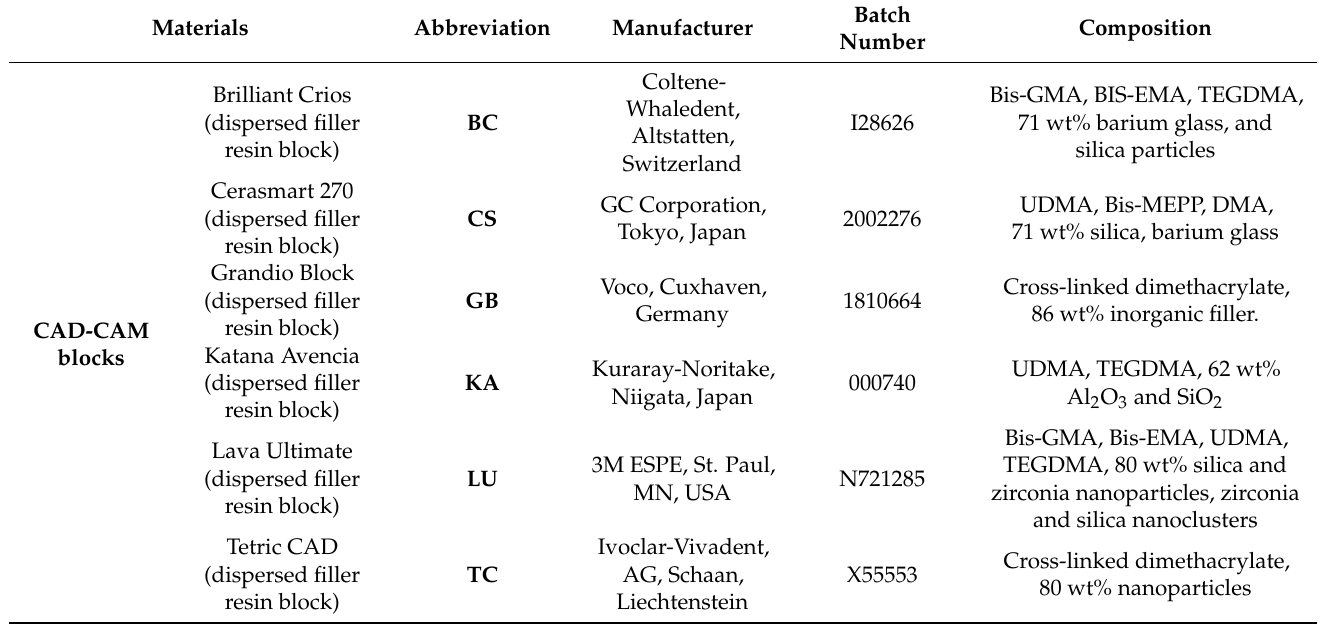
Table 1. Abbreviations, manufacturers, batch numbers and composition of the materials